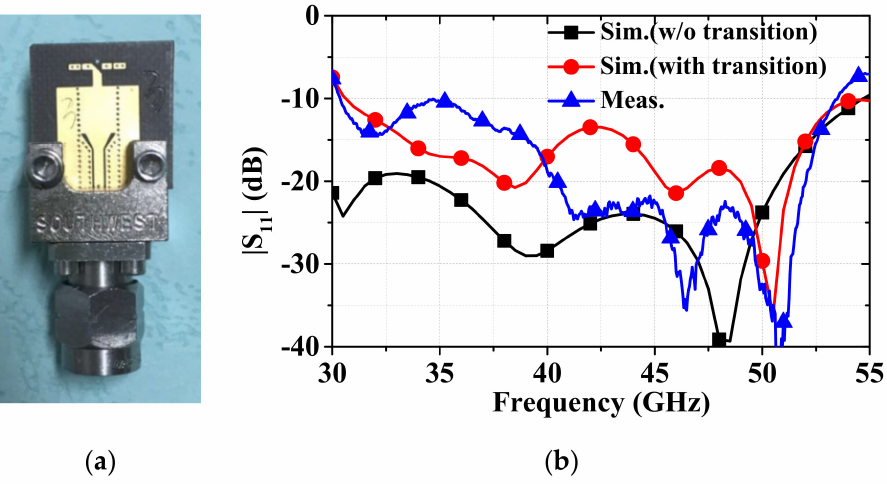
Figure 9. ( a ) The fabricated photograph. ( b ) The measured and simulated reflection coefficients of the proposed